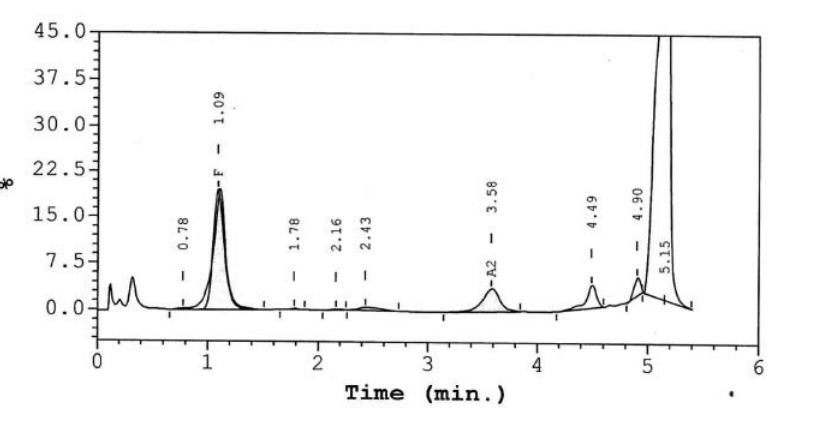
Figure 1. High performance liquid chromatography at presentation.